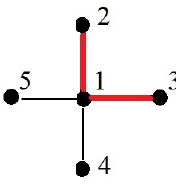
Figure 11. Star graph, n = 4. When the graph is rotated, each vertex of the graph except vertex 1 is not included in some packing, so x 2 = . . . = x 5 = 0. x 1 + x 2 + x 3 = 1 yields x 1 =